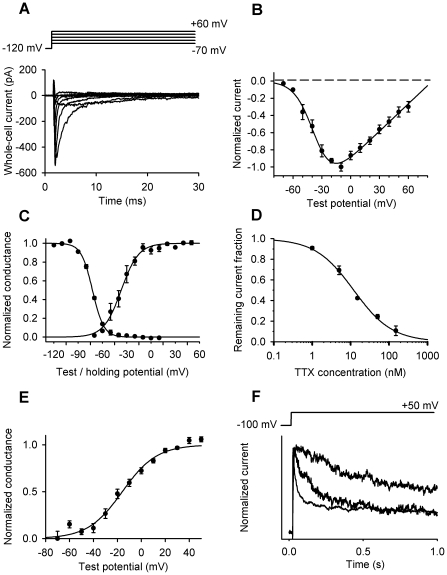
Detailed characterization of the voltage-gated Na+ and K+ currents.(A) Na+ currents evoked by depolarizing pulses from −70 to +60 mV in 10 mV increments in a 2-day-old patch-clamped differentiating chondrocyte. (B) The current–voltage relationship of the Na+ current determined from the peak current at each voltage. (C) The functions describing the voltage dependence of steady-state activation (G–V curve) and inactivation mark a potential window for Na+ channel operation. The G–V curve was constructed from the current–voltage relationship. The voltage dependence of steady-state inactivation was obtained by holding the cells at the indicated holding potentials for 15 s then the peak current was recorded during a pulse to 0 mV. Data points were fitted with Boltzmann-functions yielding the half-activation (V1/2,a = −36.8 mV) and half-inactivation (V1/2,i = −72.4 mV) voltages. (D) Dose–response function of tetrodotoxin on Na+ channels of differentiating chondrocytes. Fitting the Hill equation to the data points yielded Kd = 12 nM and nH = 0.87. (E) Voltage dependence of the steady-state activation (G–V curve) of voltage-gated K+ channels in chondrocytes. The G–V relationship was constructed from the current–voltage relationship at each test potential using Erev = −85 mV; points were fitted with a Boltzmann-function. The curve represents a mixture of KV1.1 and KV4.1 channels, and the obtained V1/2 = −15.5 mV lies between the V1/2 of those channels. (F) Normalized current traces recorded from three different cells representing the highly variable inactivation rate of the K+ current. Cells were depolarized to +50 mV for 1.5 s, the first 1 s is shown for clarity.